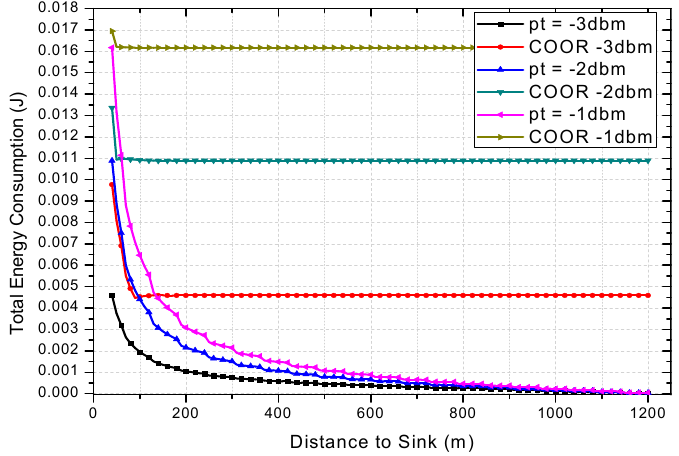
Figure 22. The effect of different initial transmission powers on energy consumption.